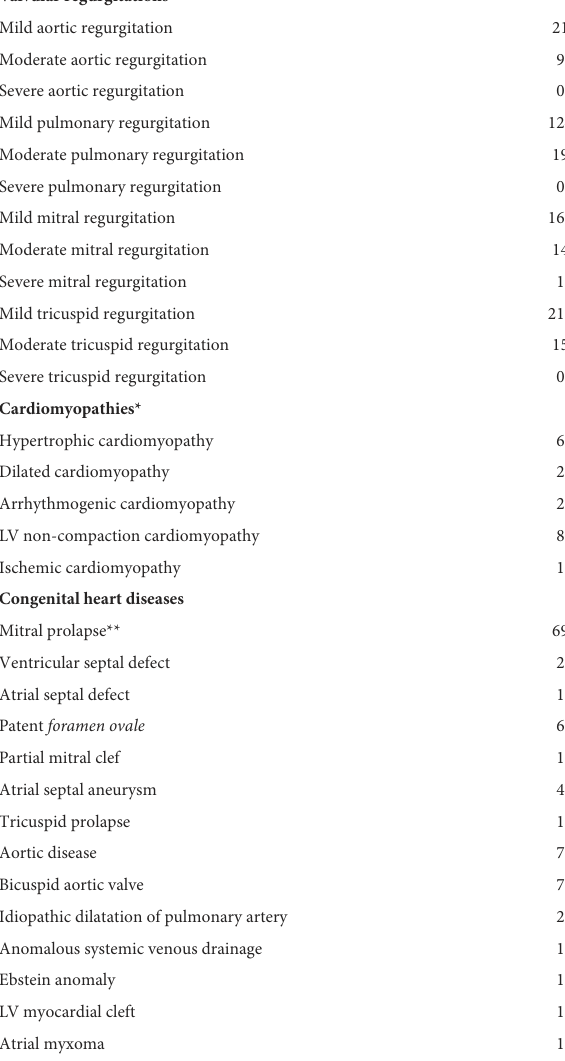
TABLE 3 Echocardiography findings in elite athletes that underwent Holter monitoring ( n =